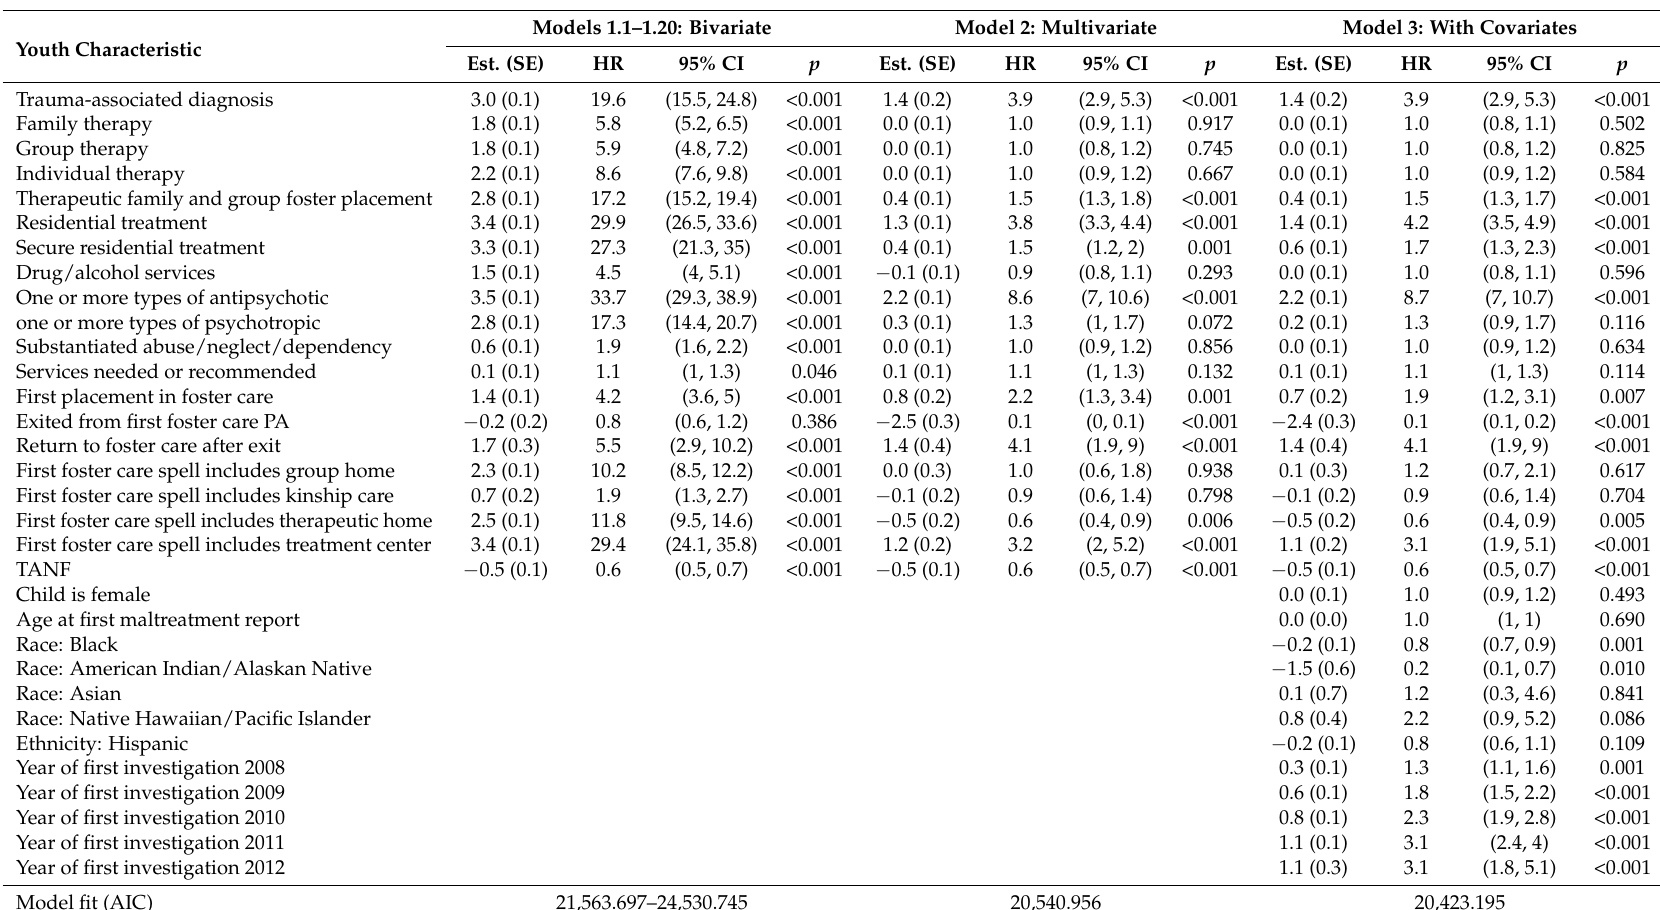
Table 2. Bivariate and Multivariate Cox Regressions Predicting PRTF Admission ( n = 105,452). Models 1.1–1.20: Youth Characteristic